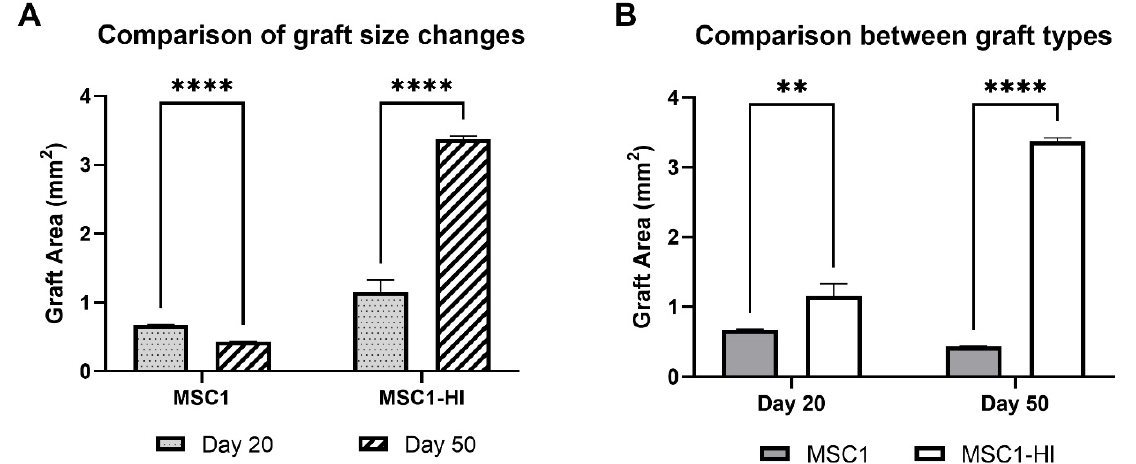
Figure 4. Comparison of graft area between MSC1 and MSC1-HI cell allografts. ( A ) Comparison of changes in graft size were measured for MSC1 and MSC1-HI cells at day 20 (dotted gray bar) and day 50 (striped bar) post-transplantation. ( B ) Comparison of sizes between the graft types at each time point were measured for MSC1 cell (gray bar) or MSC1-HI cell (white bar) grafts ( n = 3 each) at days 20 and 50 post-transplantation. Asterisks denote comparison between MSC1 and MSC1-HI cells. ** p < 0.01; **** p < 0.0001. Significance was measured using unpaired t test.